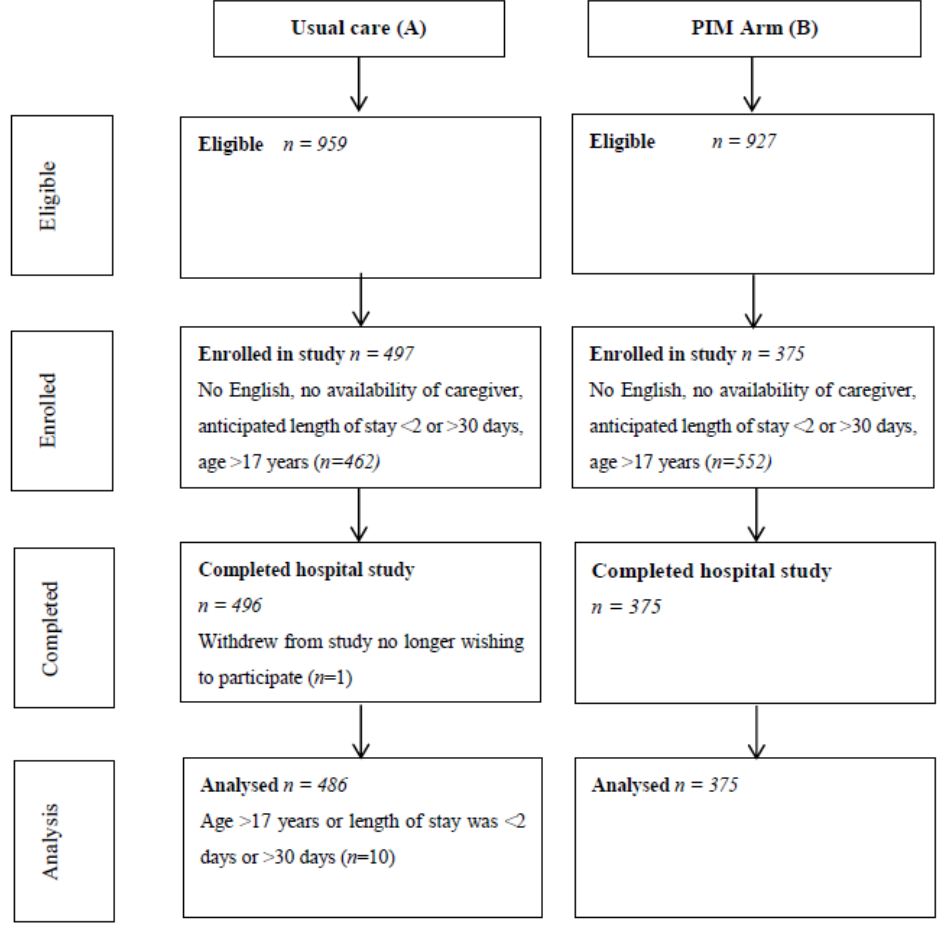
Figure 1. Participant flow.